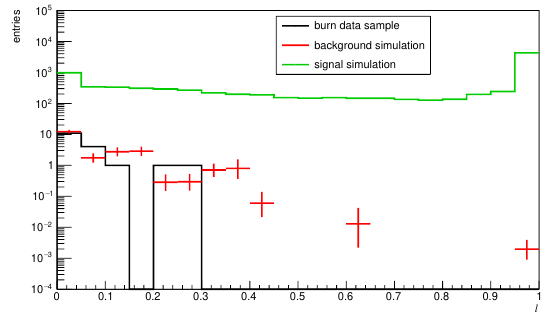
Distributions of the l quantity in the burnt dataset (black), background simulations (red), and signal simulations (green). Background simulations are weighted to the UHECR flux measured by the Auger Observatory and normalized to 10% of the data. The normalization of the signal simulations is arbi-